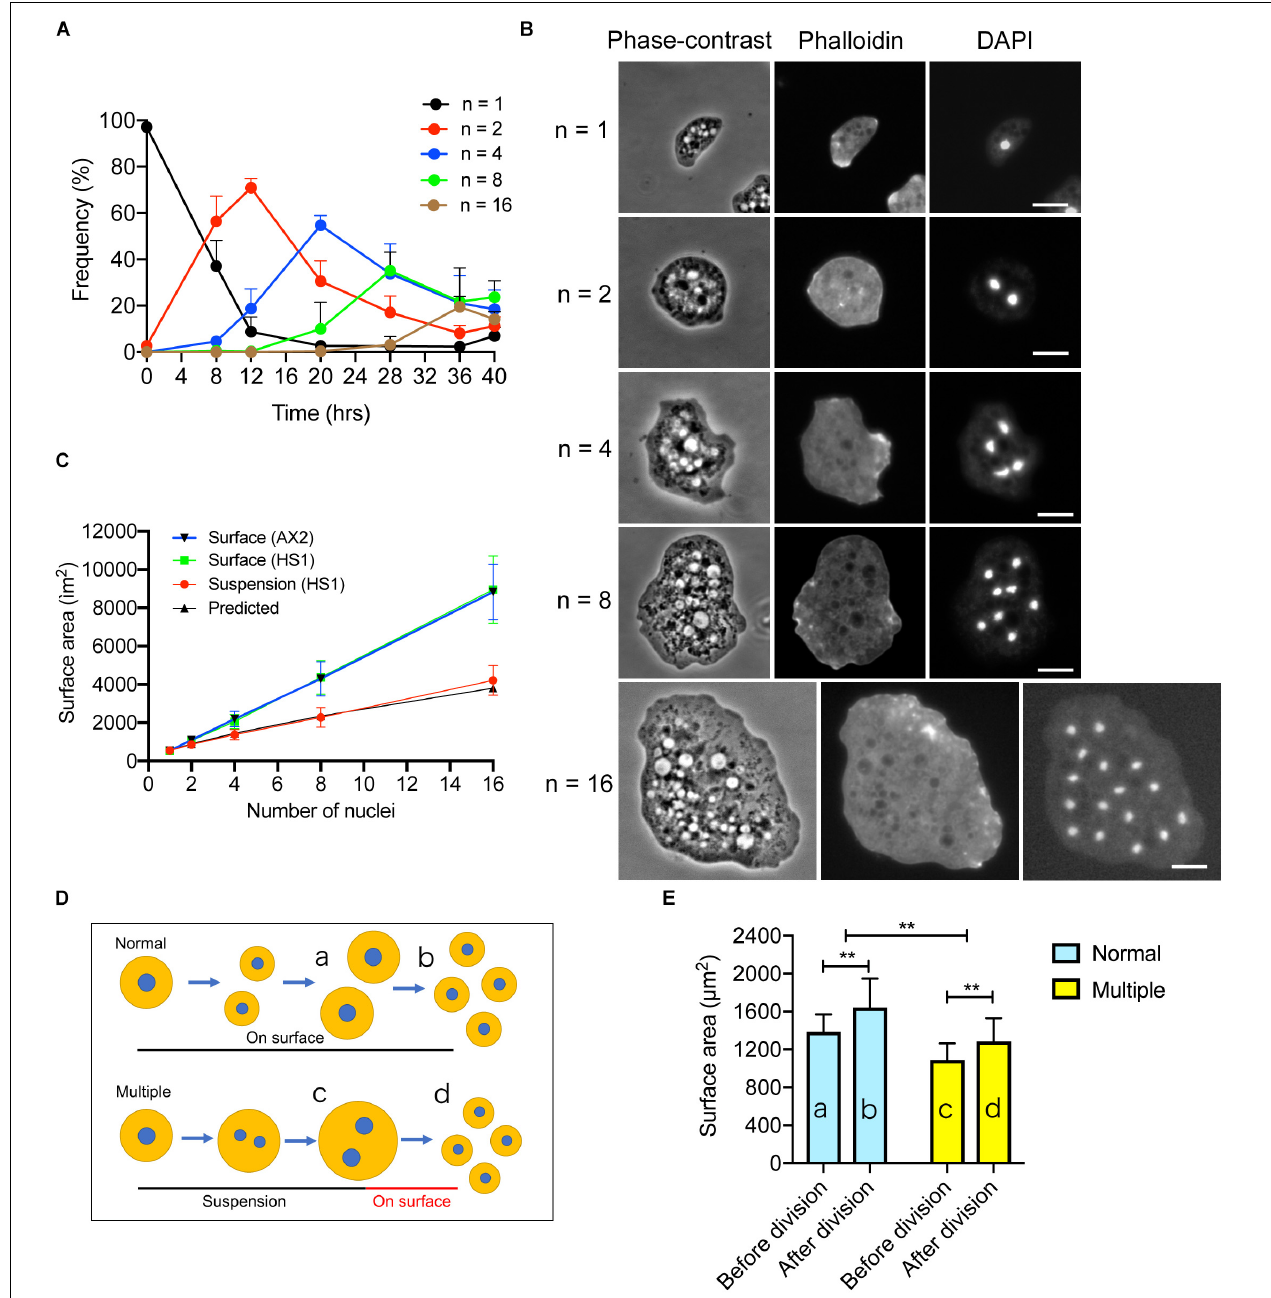
FIGURE 4 | Proper furrowing is required for the increase in surface area. (A) Time course of multinucleation of myosin II null (HS1) cells in suspension culture. The frequencies of the cells having a single, 2, 4, 8, or 16 nuclei over time. Although the cells different numbers of nuclei (3, 5, etc.) gradually increased, only the cells with single, 2, 4, 8, and 16 nuclei are plotted (mean ± SD, n > 500). (B) Typical phase-contrast and fluorescence images of HS1 cells with single, 2, 4, 8, and 16 nuclei at each peak of the graph in (A) . The cells were overlaid with agar, fixed, and stained with tetramethylrhodamine isothiocyanate (TRITC) phalloidin and DAPI. Bars: 10 µ m. (C) Surface area of HS1 cells plotted versus the number of nuclei when cells were cultured in suspension culture (Suspension HS1) and in surface culture (Surface HS1). The surface area of wild type (AX2) cells was also plotted versus the number of nuclei in surface culture (Surface AX2). Data are presented as the mean ± SD, n > 500. For the surface culture, the surface area was multiplied by the number of nuclei of the dividing cells such as 2, 4, 8, and 16. The predicted surface area (Predicted) is calculated by subtracting each area that should be incremented during the cytokinesis. (D) Scheme to explain the experiments. Multinucleate HS1 cells can divide in surface culture by binary fission (Normal). On the other hand, HS1 cells become multinucleate in suspension culture. The multinucleate cells can then divide by attaching to the surface (Multiple). The cell surface areas were compared before (a,c) and after (b,d) division. (E) The cell surface areas in the experiments shown in (D) are compared for Normal and Multiple. Data are presented as the mean ± SD and analyzed by Student’s t -test. ** P ≤ 0.001, n > 130.